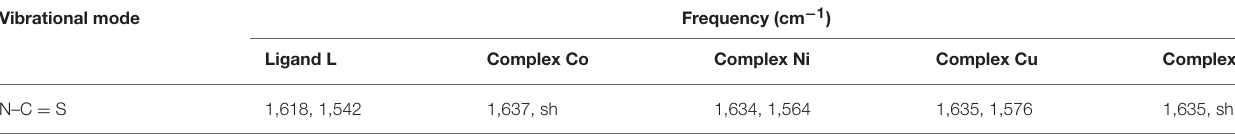
TABLE 1 | IR spectral data (cm − 1 ) of the ligand and its corresponding complexes in KBr pellets. Vibrational